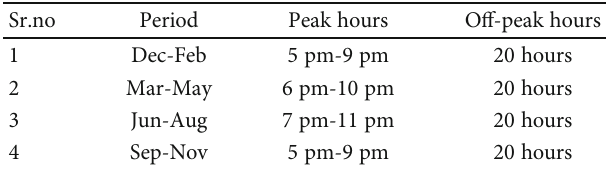
Table 9: Peak/o ff -peak timing.